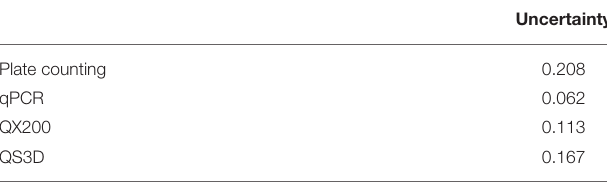
TABLE 6 | Level of uncertainty relative to L. monocytogenes for all the